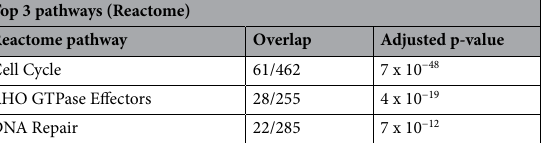
Table 2. Table summarizing the top three most impacted pathways by the most differentially expressed genes obtained through RNA-Seq analysis (Ratio > 1.5 on Vehicle-treated samples), according to the Reactome tool.